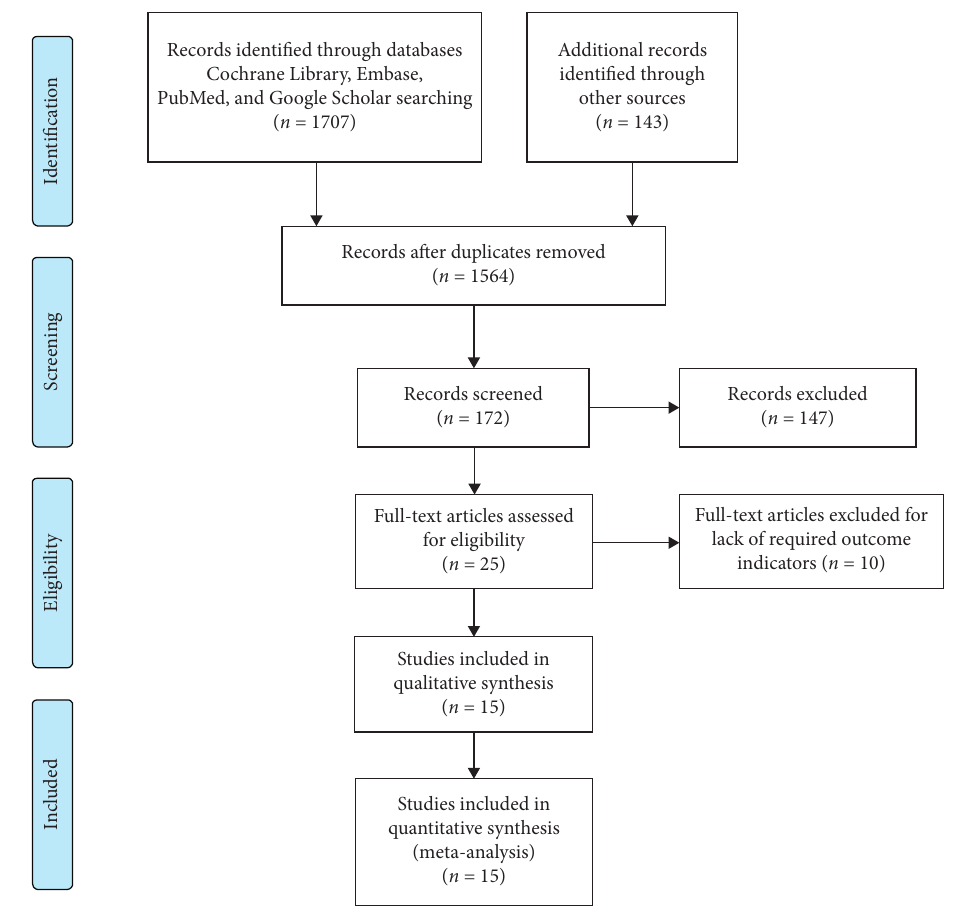
Figure 1: Flow diagram of the study selection process. Table 1: Characteristics of studies included in the